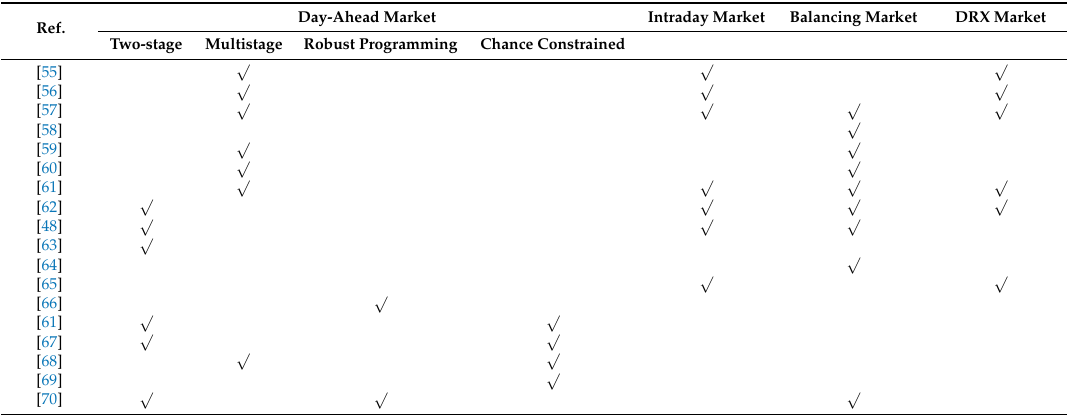
Table 1. Taxonomy of different markets and relevant